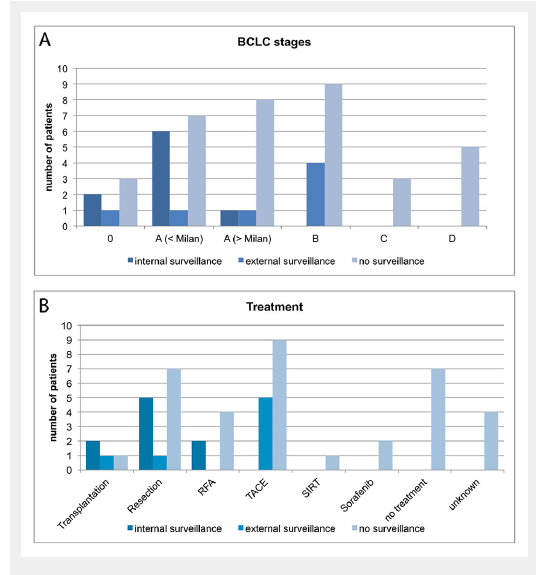
(A) Barcelona Clinic Liver Cancer (BCLC) staging of internal surveillance (dark blue), external surveillance (blue), no surveillance (light blue). Stages 0 and A are considered as very early and early stages. BCLC stage A patients were subdivided in those within the Milan criteria, and those with tumours outside the Milan criteria. (B) Applied treatments for HCCs detected in internal surveillance (dark blue), external surveillance (blue), or in patients without surveillance (light blue). HCC = hepatocellular cancer; RFA = radiofrequency ablation; SIRT = selective internal radiotherapy; TACE = transarterial chemoembolisation